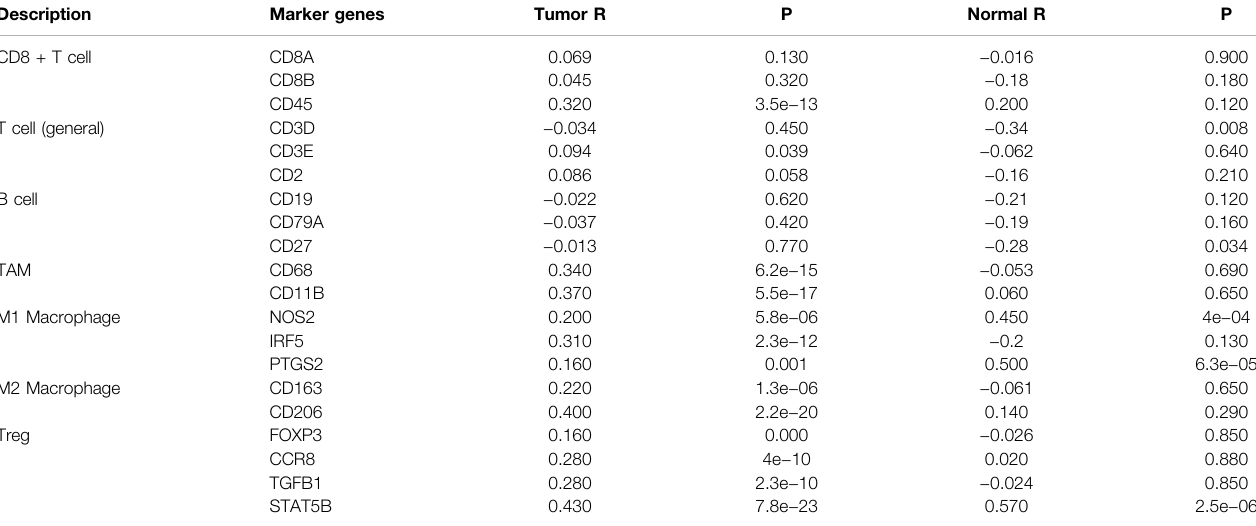
TABLE 4 | Correlation analysis between RAB11FIP1 and TIICs marker genes in GEPIA.